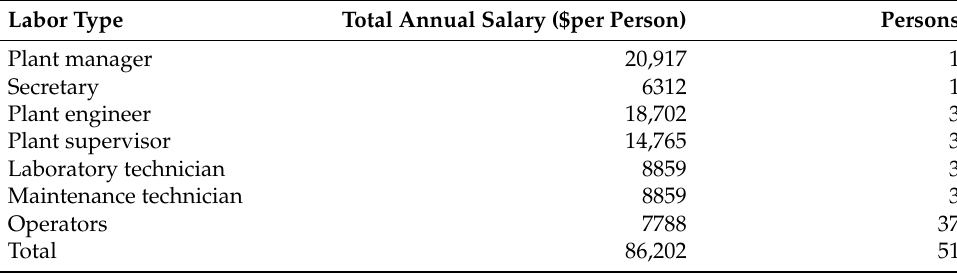
Table 5. Quantity and cost of labor used for the techno-economic assessment of the simulated processes. Labor